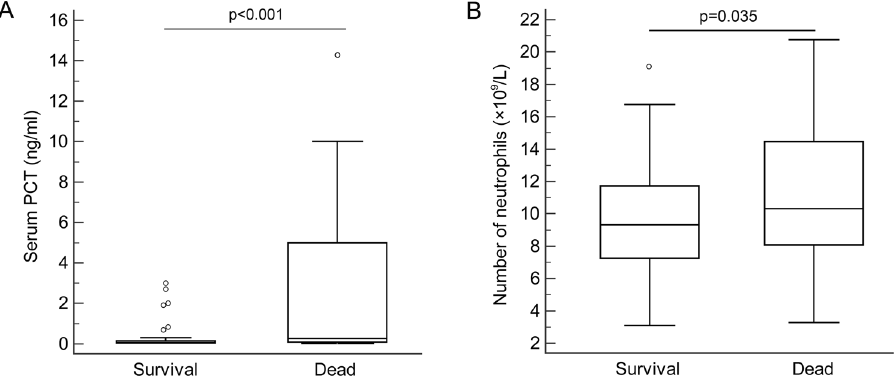
Figure 2. Distributions of serum levels of PCT and neutrophil counts in survivors and non-survivors. The range of variation of serum PCT levels ( A ) and neutrophil counts ( B ) is displayed with box plots. IQR is denoted with an open box; maximum, minimum, and median values are denoted by top, bottom, and middle lines, respectively. Outliers are denoted by circles. P < 0.001 or = 0.035 dead versus survival, n = 68 for survivors and n = 25 for non-survivors.